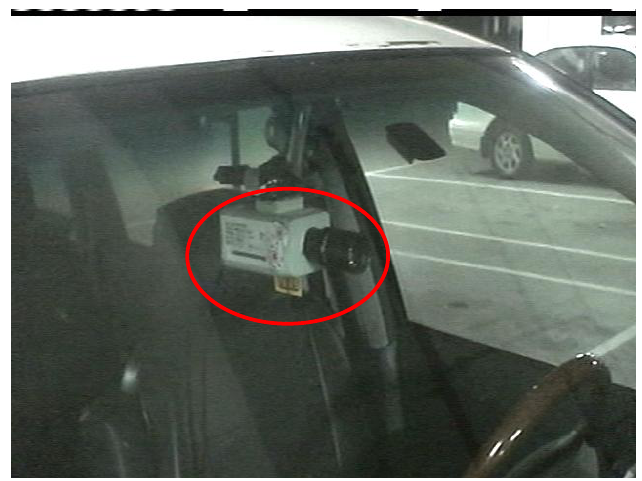
Figure 15. Proposed system software architecture.